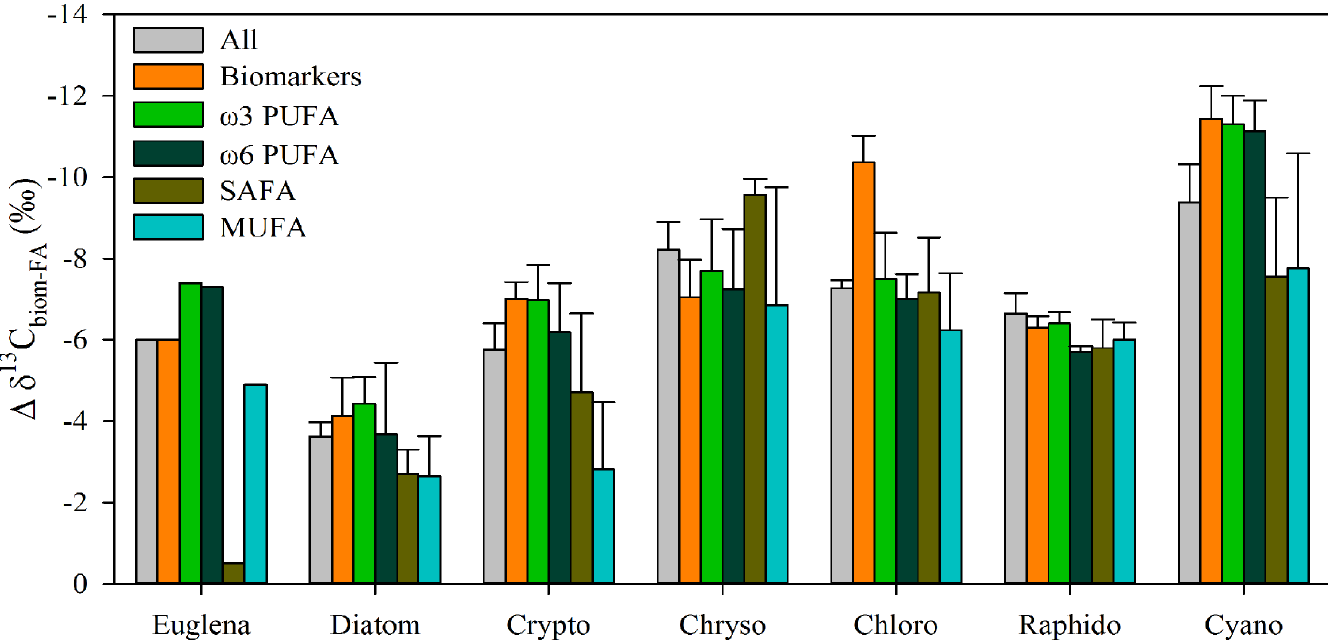
Fig 2. Isotopic difference between fatty acid and bulk biomass of freshwater phytoplankton. The carbon isotopic difference ( Δ δ 13 C, mean ± SD) between fatty acid groups and bulk biomass varied amongst the phytoplankton classes.